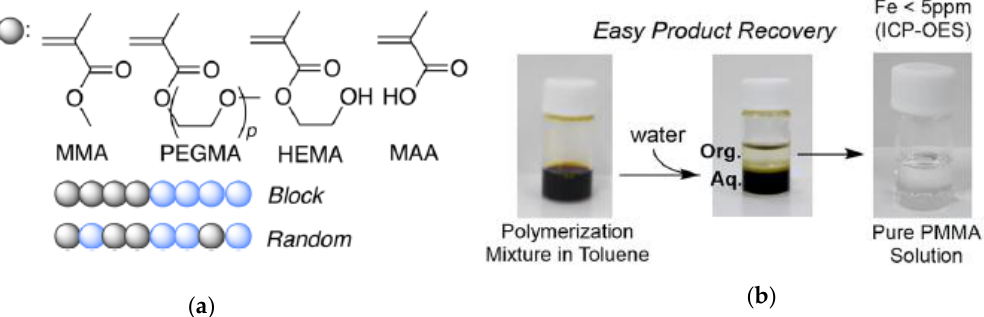
Figure 9. Different alkyl methacrylate monomers employed for the synthesis of block and random copolymers using iron-containing SCNPs as enzyme-mimetic catalysts ( a ); and easy recovery of nearly pure product (Fe content < 5 ppm) after polymerization ( b ) (reprinted from [29] with permission, Copyright American Chemical Society,